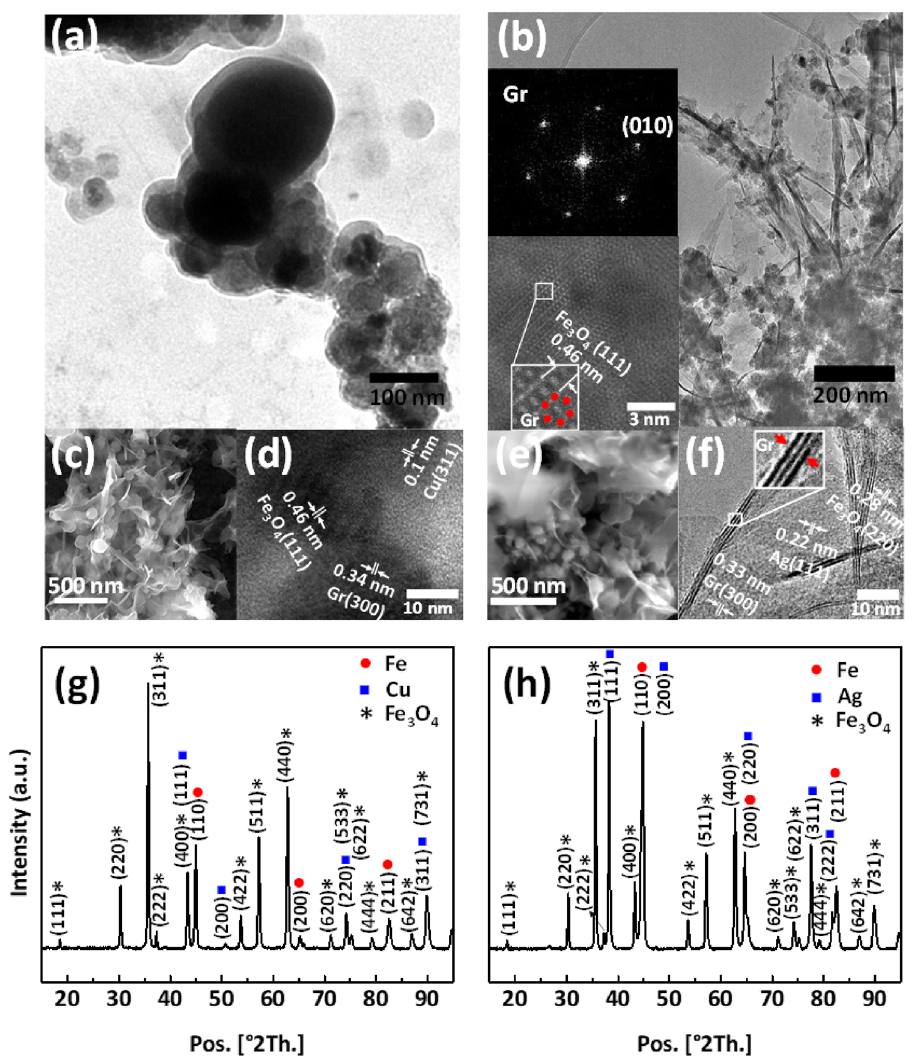
Figure 3. ( a, b ) TEM images of composites including GFC ( a ) and GFA ( b ) composites. The TEM images show that the 2D flakes have been decorated with metallic NPs. Fast Fourier transform in ( b ) (the top left inset) shows the graphene crystal in GFA composite. The bottom left image in ( b ) also exhibits that the sheets have four layers, confirming an ultrathin morphology of graphene. ( c )The FESEM and ( d ) HRTEM images of the GFC composite. ( e ) The SEM and ( f ) HRTEM images of the GFA composite. The SEM/FESEM images confirm the TEM results. The graphene (Gr), Ag, Cu, Fe, and Fe 3 O 4 crystals could be clearly determined in the HRTEM images. ( g, h ) XRD patterns of composites, including GFC ( g ) and GFA ( h ) composites. All two plots illustrate metal and metal oxide phases which had been confirmed by HRTEM